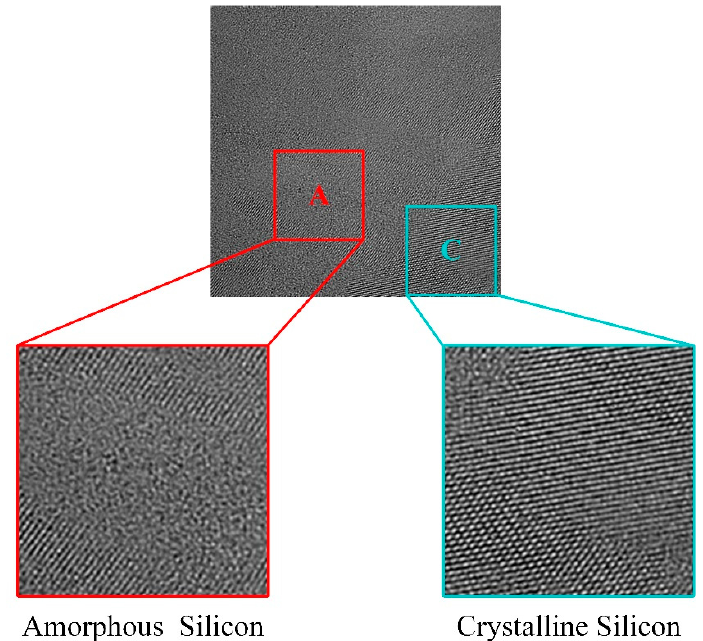
Figure 6. High-resolution TEM photograph in grain boundary. The zoom in area A shows the amorphous silicon part, and the zoom in area C shows the crystalline silicon part.